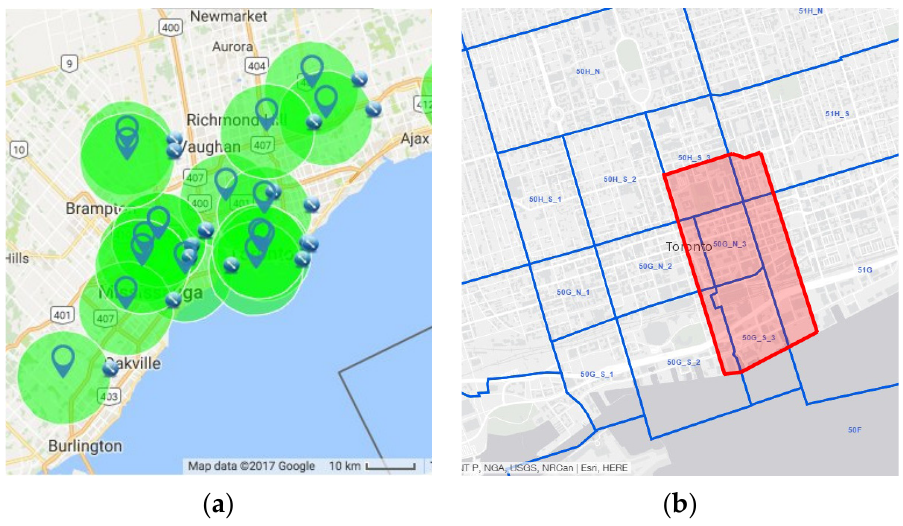
Figure 2. The study area ( a )—( left ) Macroscale Toronto city map showing all airfields.; ( b )—( right ) Study area in old Toronto [53,54].